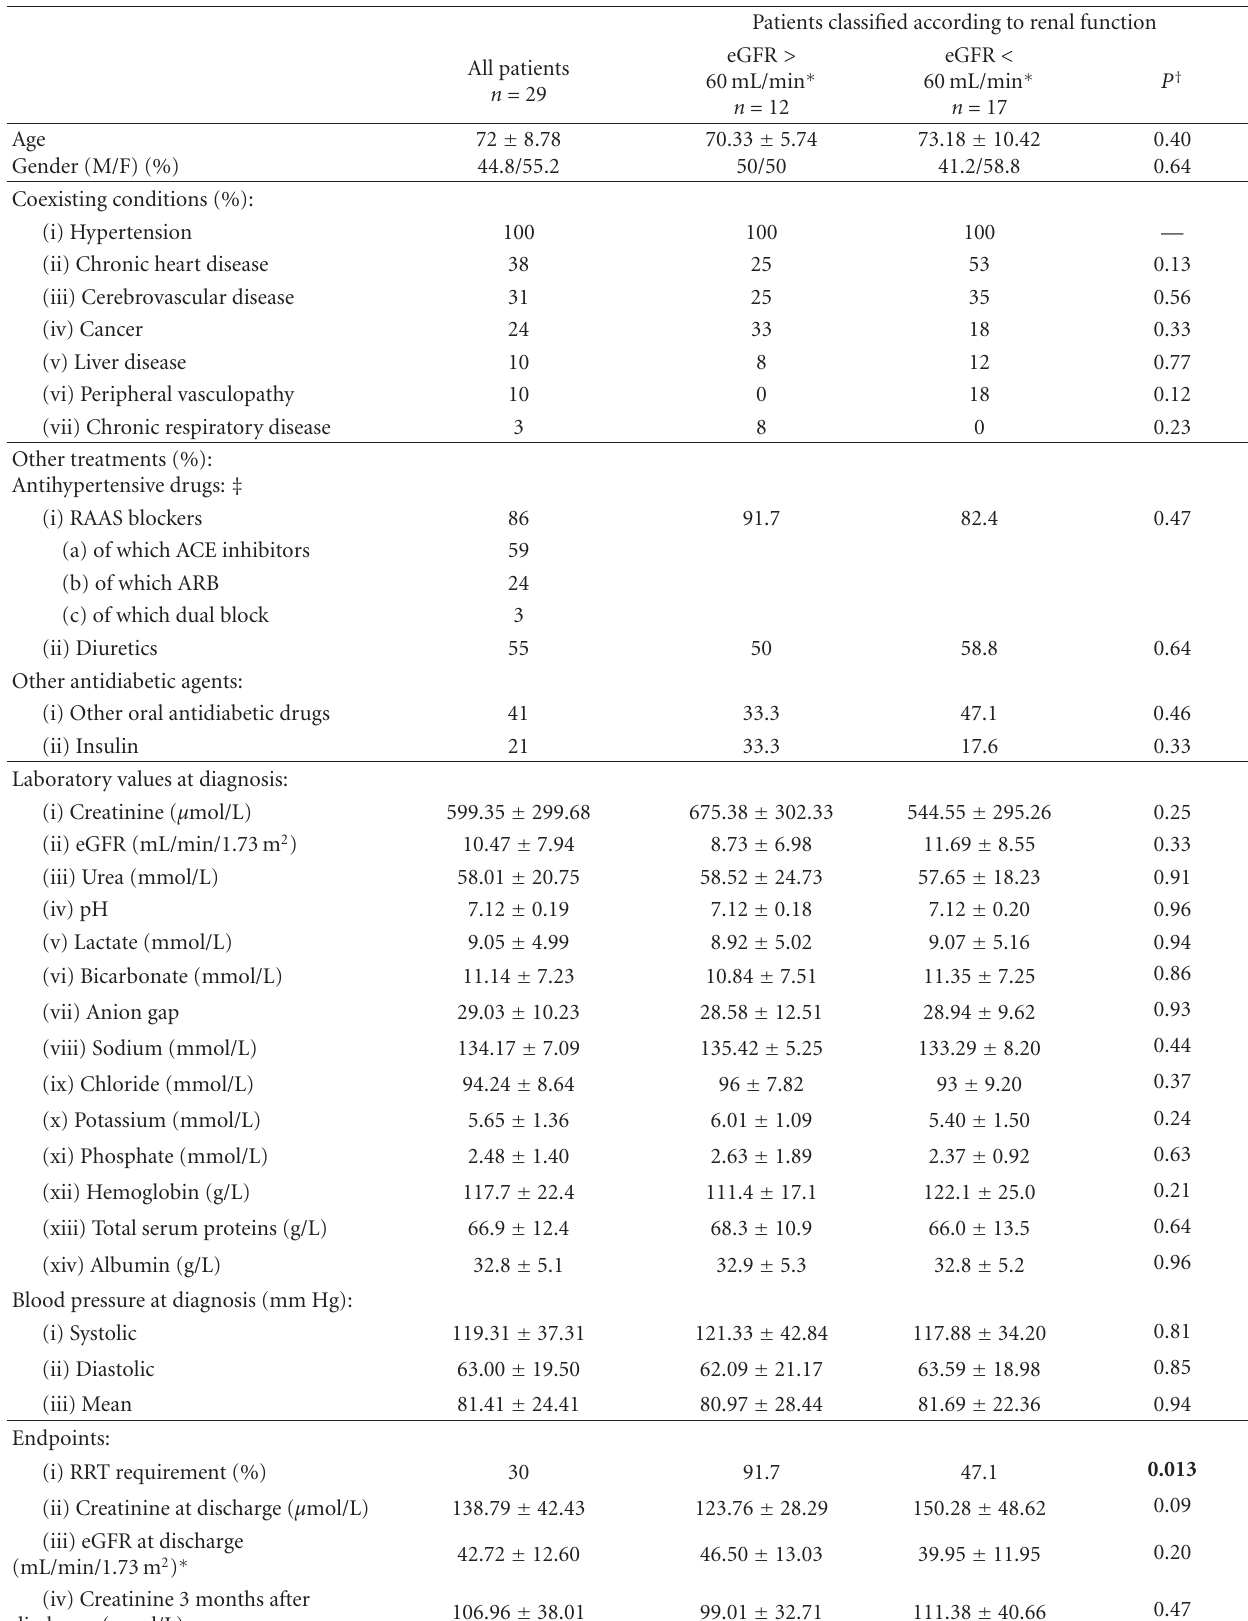
Table 1: Clinical and analytical characteristics of the patients. Patients classified according to renal